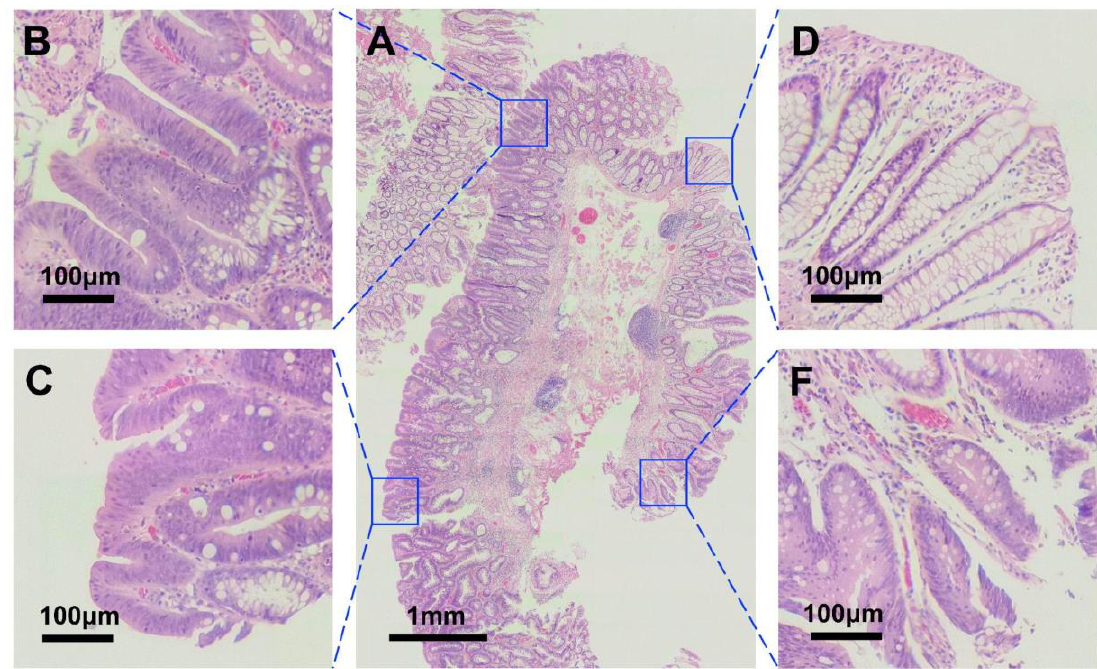
Figure 7. ( A ) Stitched scan image (20 × 20 grid) of a colon tubular adenocarcinoma histology sample. ( B – F ) High magnification images showing different structures of interest.